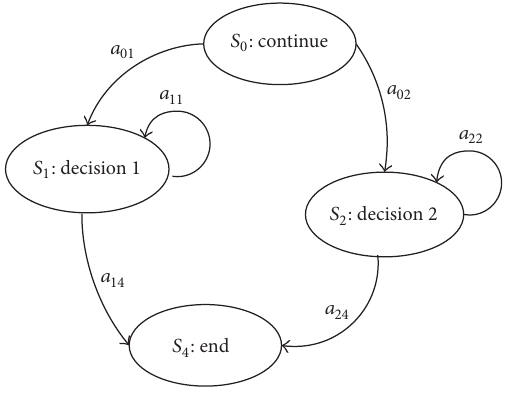
Figure 5: Simple DSS model with two possible metastates. “Con- tinue” metastate refers to vehicle proceeding with no change. 𝑆 1 and 𝑆 2 could correspond to driver decisions such as stop and turning right. Notional metastate transition probabilities are